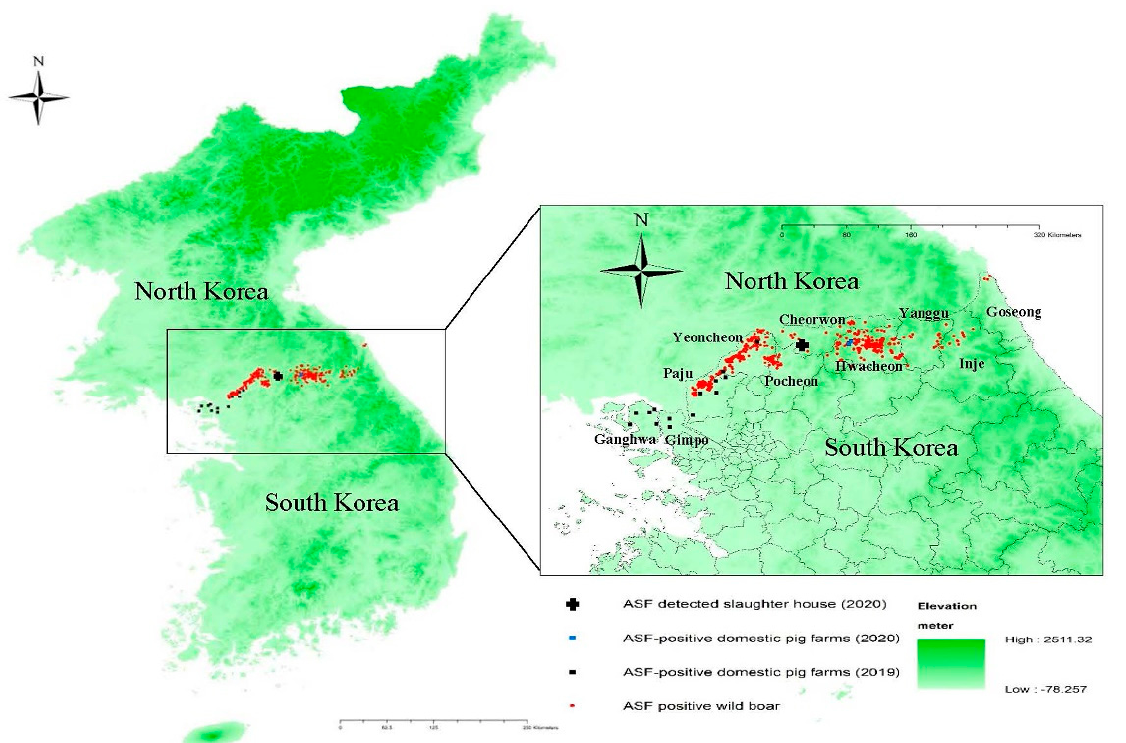
Figure 1. Map of African swine fever outbreaks in South Korea from 16 September 2019 to 10 October 2020, with the elevation of lands. The black rectangles and blue rectangles indicate ASF-positive domestic pig farms in 2019 and 2020, respectively. The red circles show the location of ASF-infected wild boars detected since 3 October 2019. The black cross indicates the location of the abattoir where ASF-infected pigs were detected in 2020. The degree of darkness of green on the map shows elevation of lands ranging from − 78.28 to 2511.32 m from ground surface.